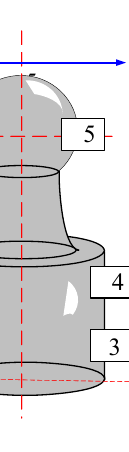
Figure 1. Drawing of a gyroscope pivot bearing.